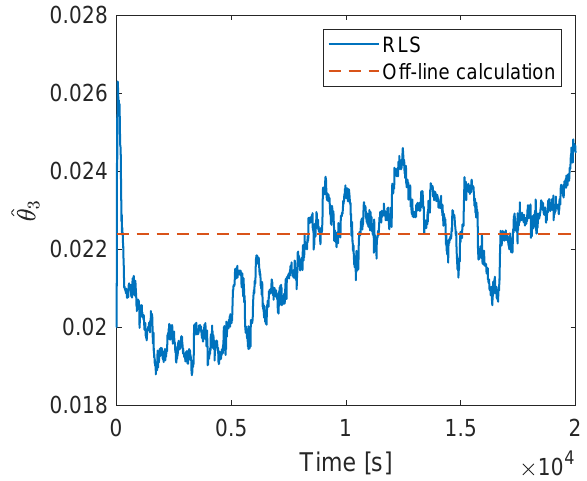
Figure 7. Comparison of the estimated results of parameter θ 3 .